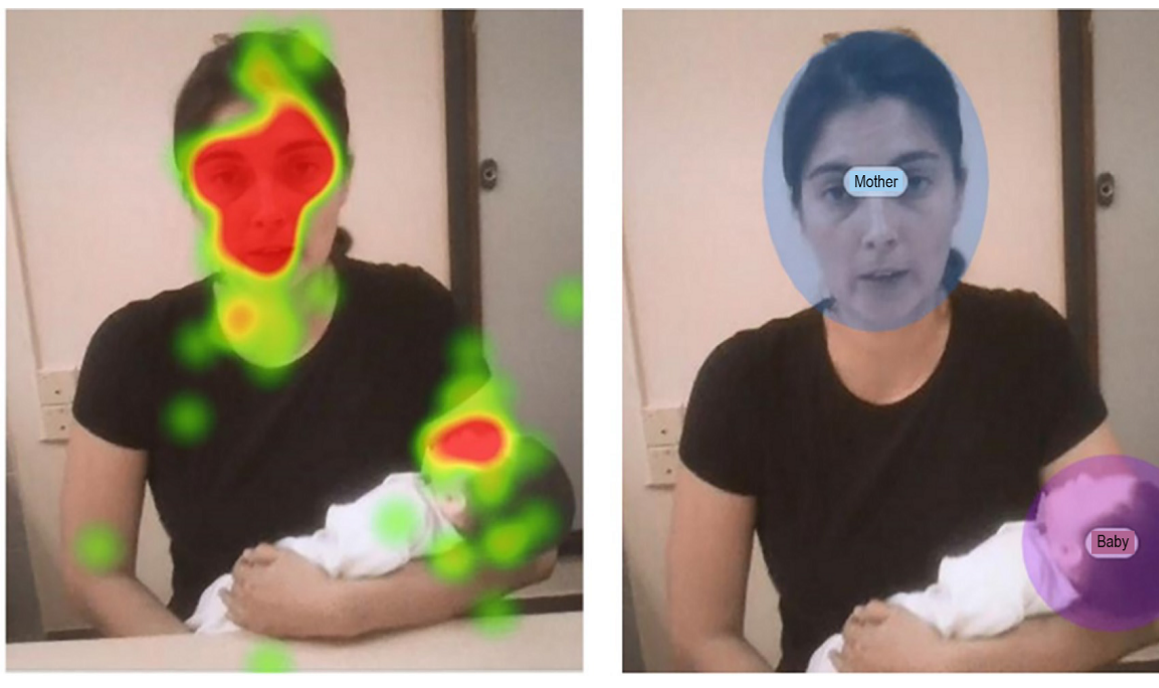
Figure 2. The areas of visual interest were the faces of the mother and the infant.